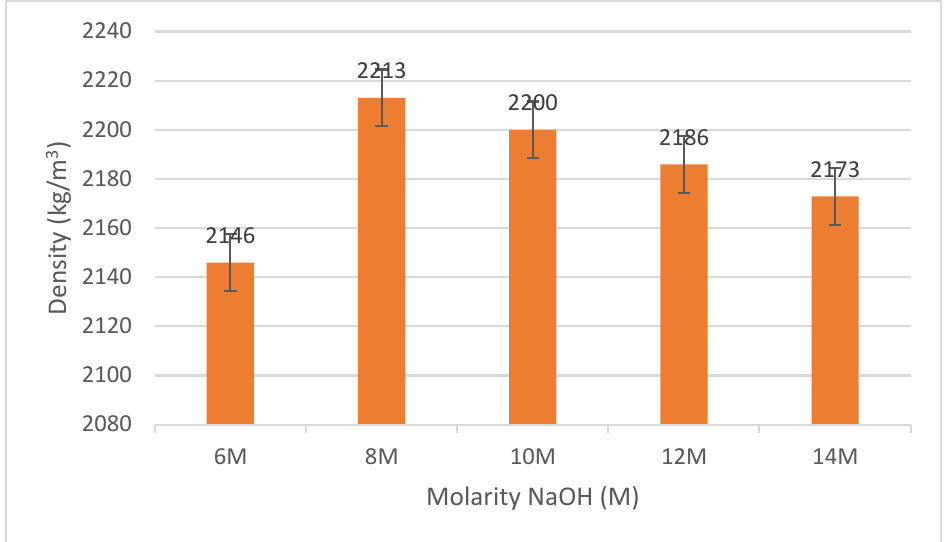
Figure 3. Density of fly ash/dolomite geopolymer.